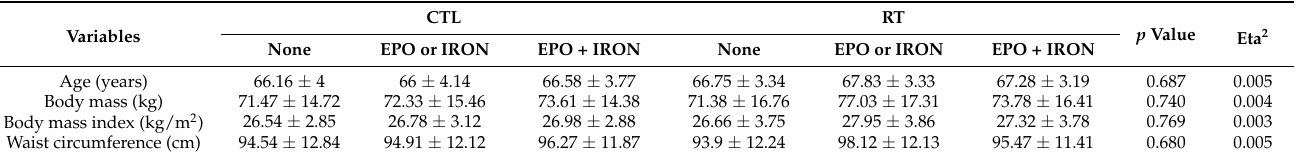
Table 1. Baseline characteristics for each group according to iron treatment.